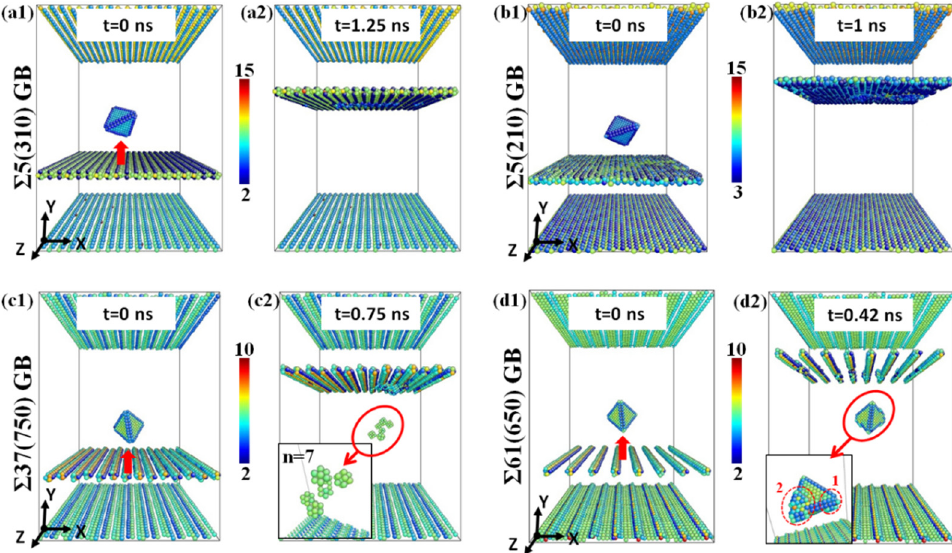
Figure 5. Snapshots of the atomic images before and after the interaction between SFT and different GBs at 10 K. ( a1 , a2 ) Σ 5(310) GB; ( b1 , b2 ) Σ 5(210) GB; ( c1 , c2 ) Σ 37(750) GB; and ( d1 , d2 ) Σ 61(650) GB. The atoms are colored according to centrosymmetry value, FCC atoms not shown. Reproduced with permission from Ref. [73]. Copyright 2021 Clearance